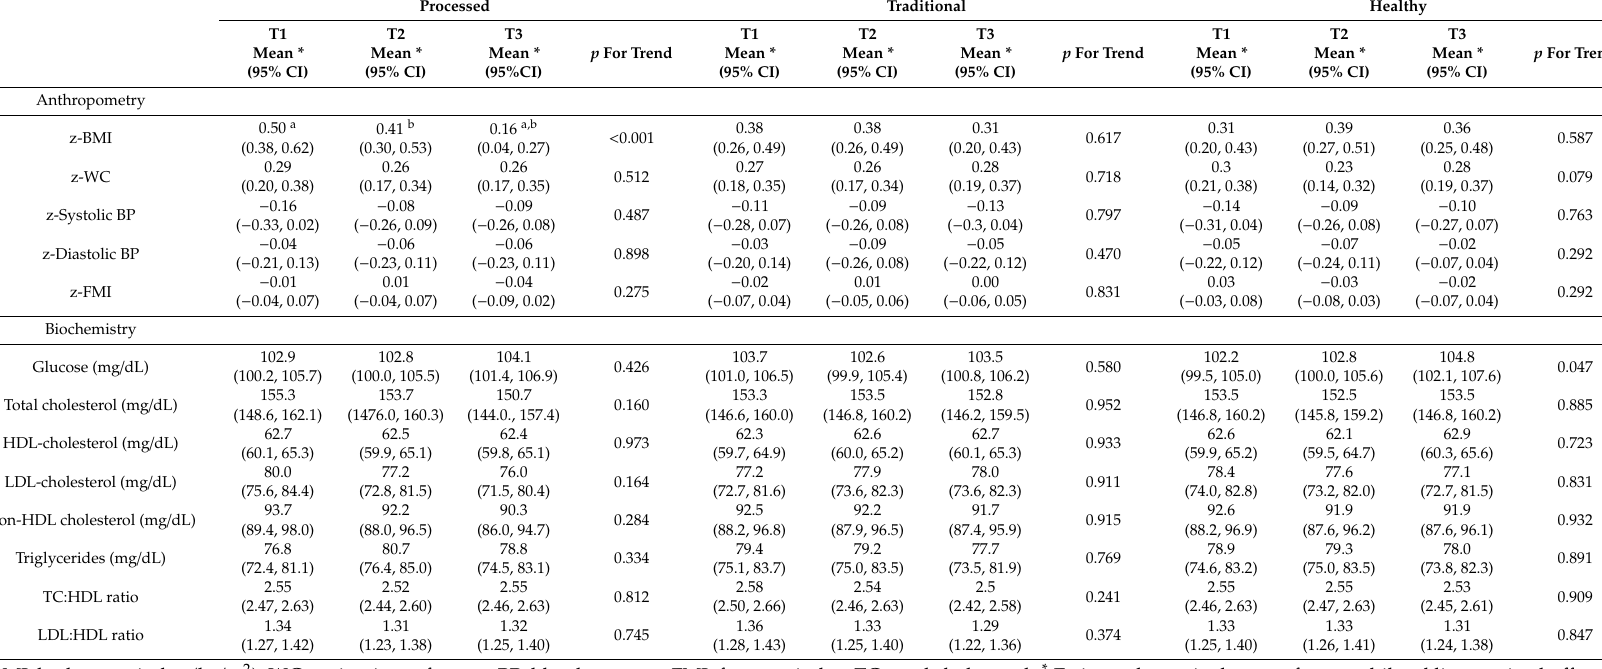
Table A1. Cardiovascular risk factors of participants according to tertiles of principal component analysis (PCA).